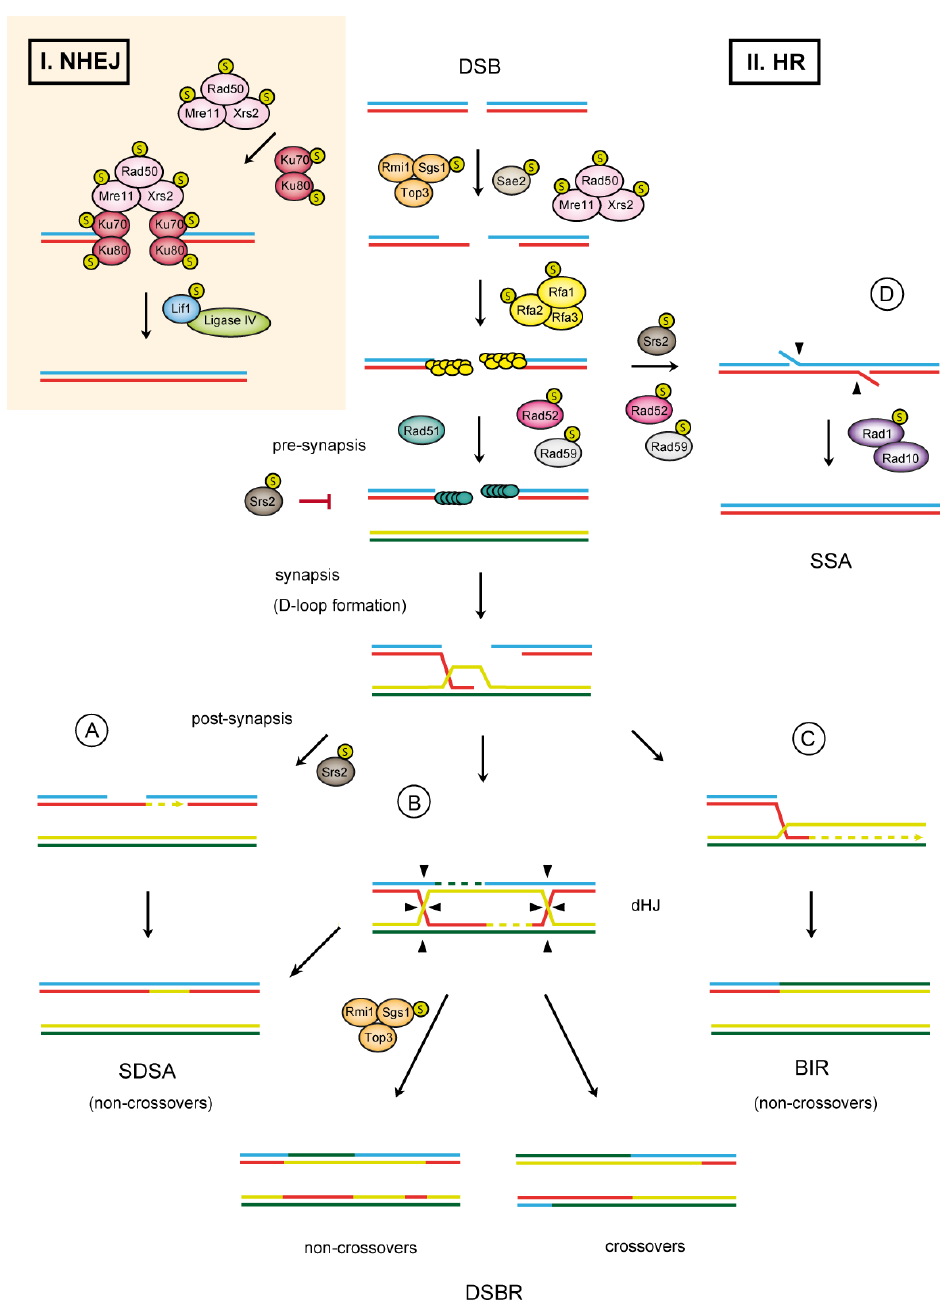
Figure 1. The double-strand break repair pathways in S. cerevisiae . After DNA damage, DSBs can be either resected to generate 3’ ssDNA tails and directly ligated by non-homologous end joining (NHEJ) (I) or processed by homologous recombination (HR) (II). In HR, resection of a DSB is followed by formation of a Rad51 presynaptic filament invading into the homologous strand to form a D-loop structure. The invading strand is then extended by DNA synthesis. The resulting extended D-loop could then be processed by one of three alternative mechanisms: synthesis-dependent strand annealing (SDSA) ( A ); double-strand break repair (DSBR) ( B ); or break-induced replication (BIR) ( C ); Proteins pathway–single strand annealing (SSA)–can be used for DSBs occurring between repeated DNA sequences ( D